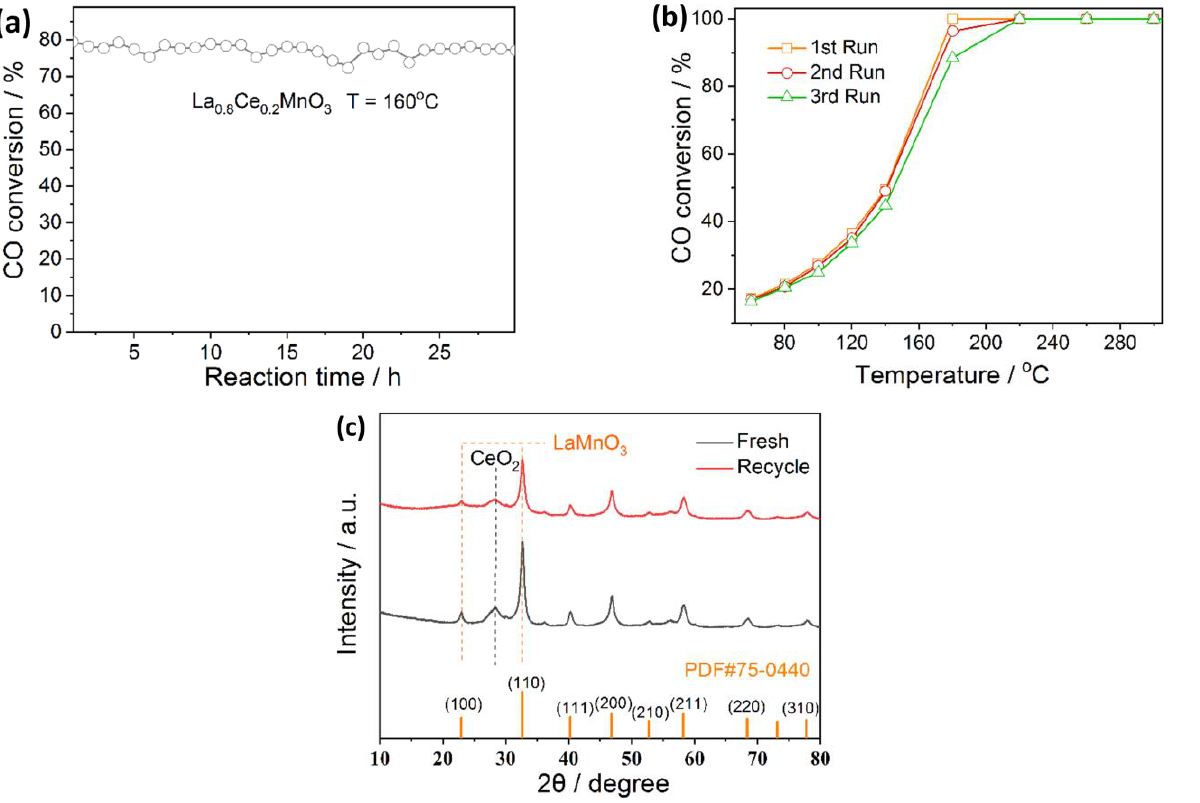
Figure 7. ( a ) Long-term and ( b ) cycling stability of La 0.8 Ce 0.2 MnO 3 for CO oxidation; ( c ) XRD patterns of the fresh and used La 0.8 Ce 0.2 MnO 3 catalyst. Reaction conditions: 0.5% CO, 6.5% O 2 , and balance gas Ar.